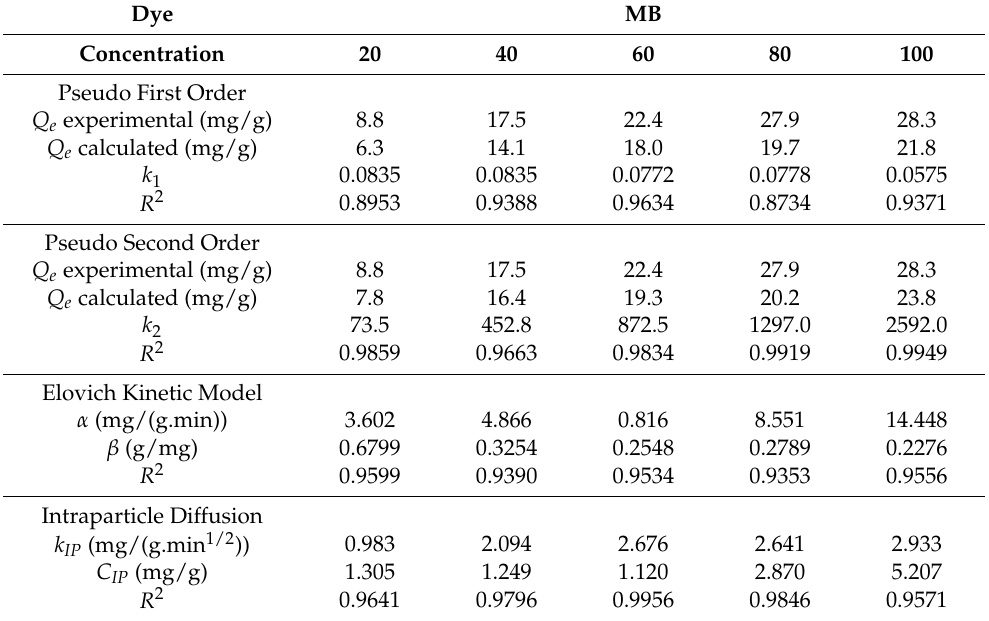
Table 1. Parameters for the pseudo-first order, pseudo-second order, Elovich kinetic model, and intraparticle diffusion for